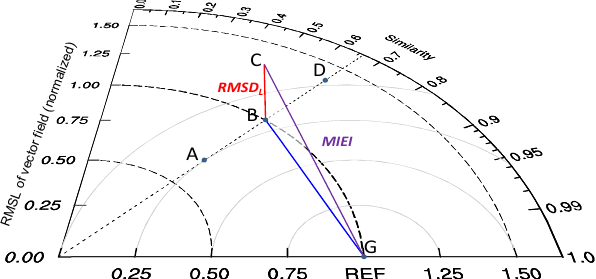
Figure 3. Schematic diagram displaying the relationship between the RMSVD, RMSD L , and MIEI. The points A, B, and D represent different models. The RMSD L measures the overall difference be- tween the modeled rms values and the observed ones. The line seg- ment BC is vertical with respect to the VFE diagram. The length of line segment BG is determined based on the vector field similarity, which measures the overall pattern similarity of various scalar fields relative to the observed ones. Thus, the MIEI index takes both the pattern similarities and the rms values of various scalar fields into